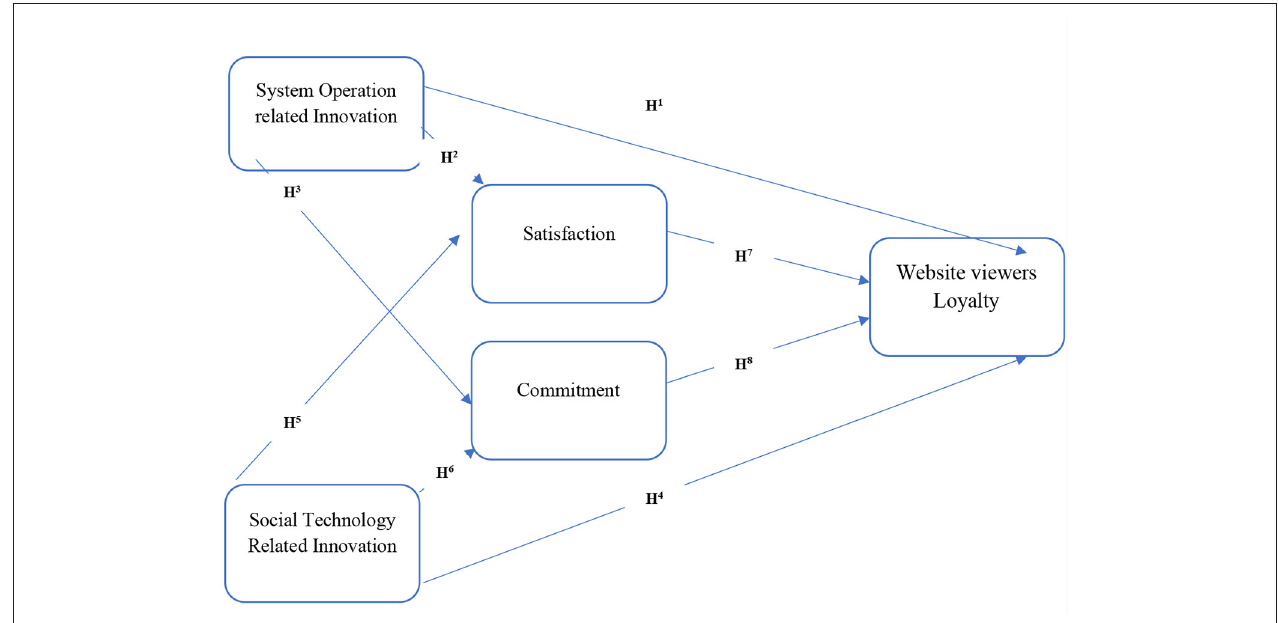
FIGURE 1 | Theoretical framework.